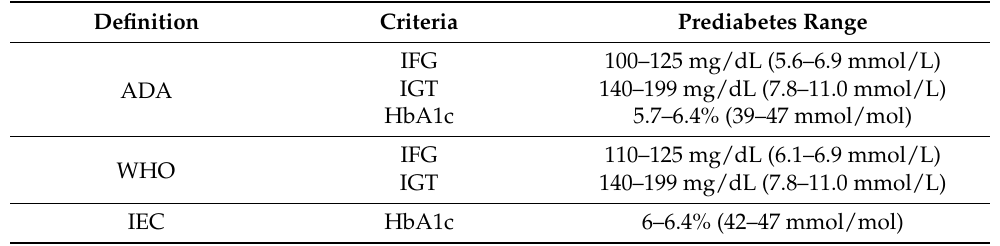
Table 1. Definitions of prediabetes